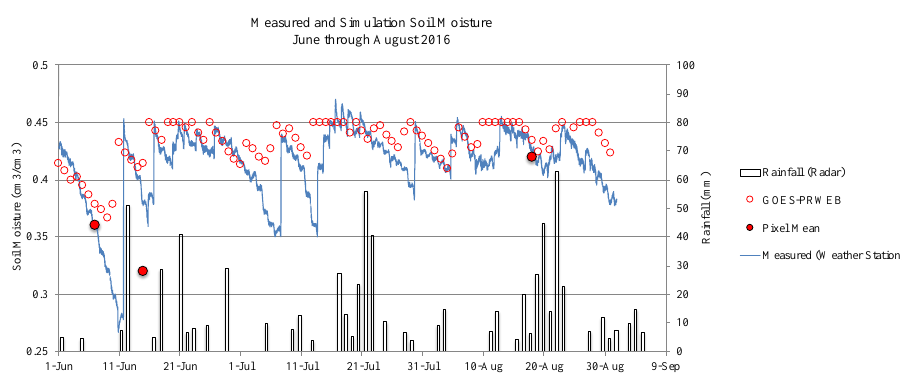
and 5 December 2015, with GOES-PRWEB θ estimates and weather station θ sensors.